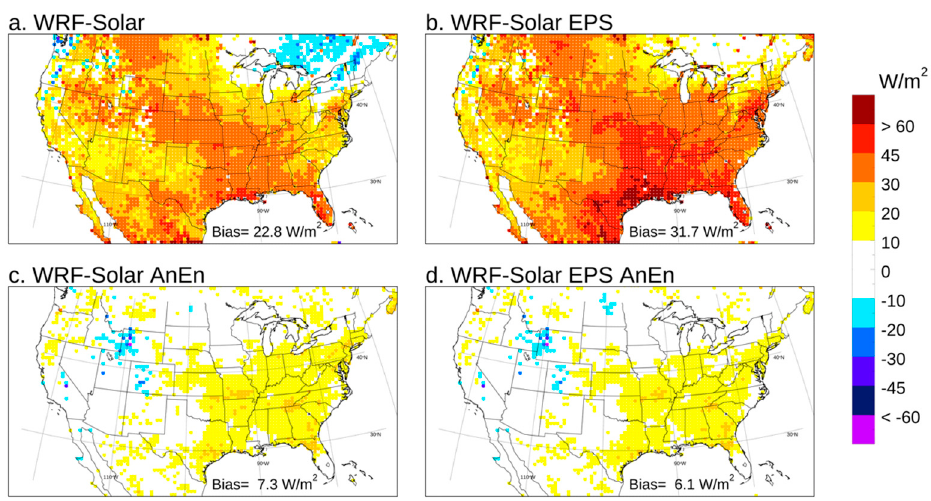
Figure 2. Bias computed for GHI over 2018 for the forecast lead times from +24 to +48 h. The value in the legend at the bottom of each panel indicates the bias computed by pooling all the grid points and lead times together.